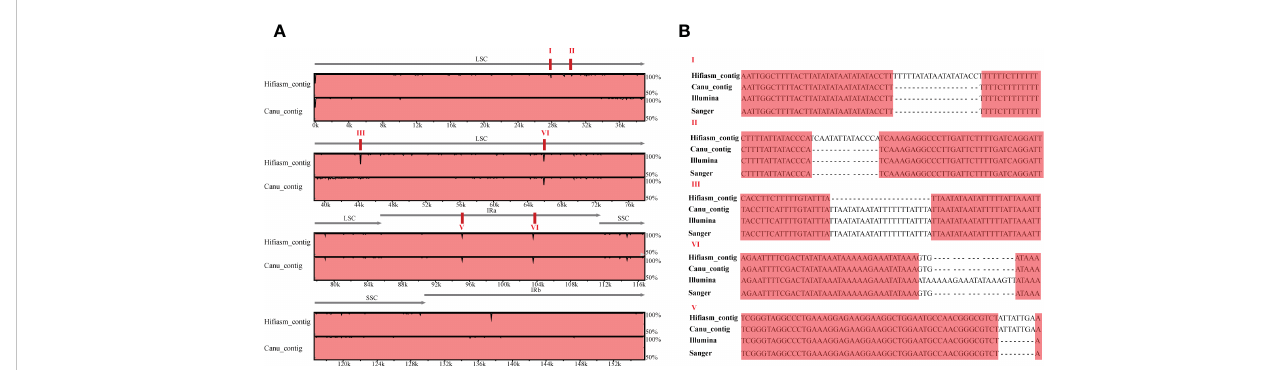
FIGURE 2 Visualized alignment and identity percent among the Fragaria chloroplast genomes based on three assembly methods relying on short- and long-read sequencing. (A) The fi gure was generated using mVISTA. The visible “ peaks and valleys ” graph shows the pairwise sequence alignement identity with the